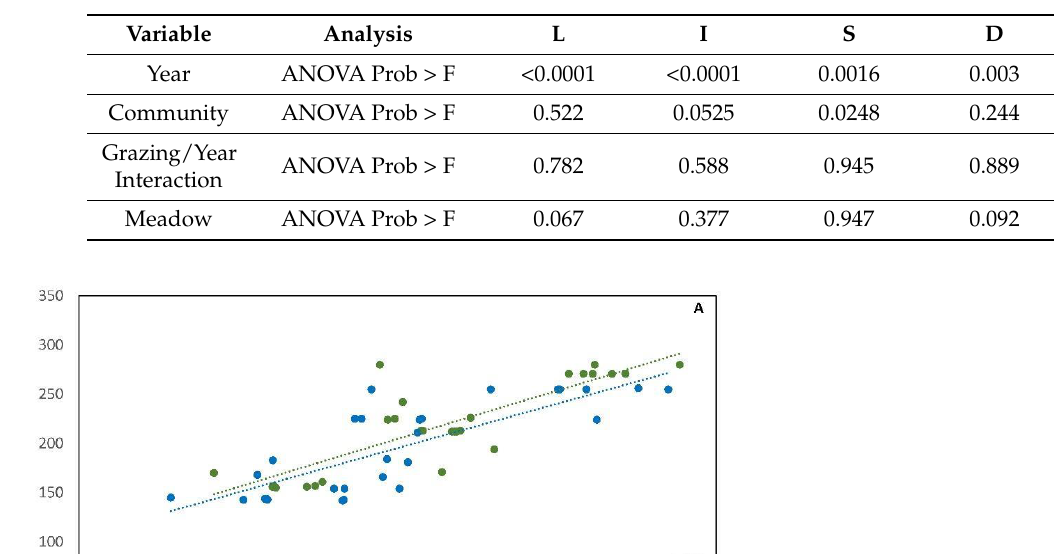
Table 4. p -values for vegetation community types, years, meadows and grazing interactions derived from factorial ANOVAS, across all maximum percentages of observance for each phenology stage. Phenology stages are leaf growth (L), inflorescence (I), seed (S), and desiccated (D).